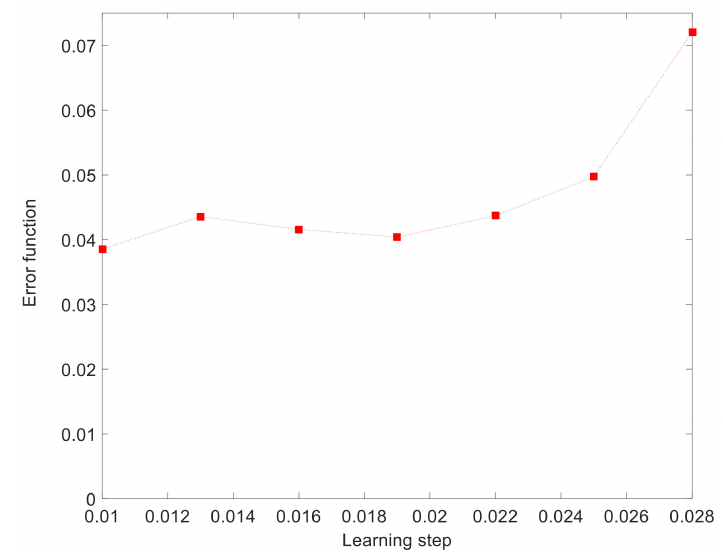
Figure 3. Error function as a function of the learning